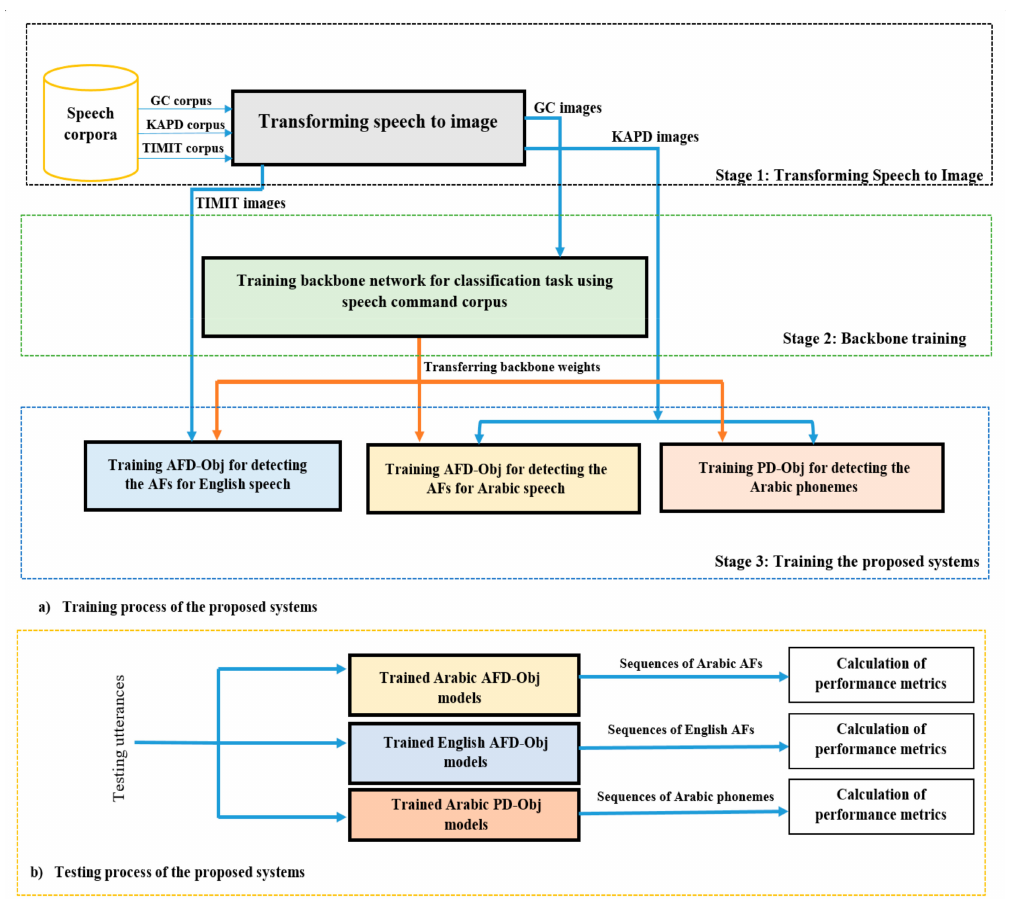
Figure 5. General overview of the proposed